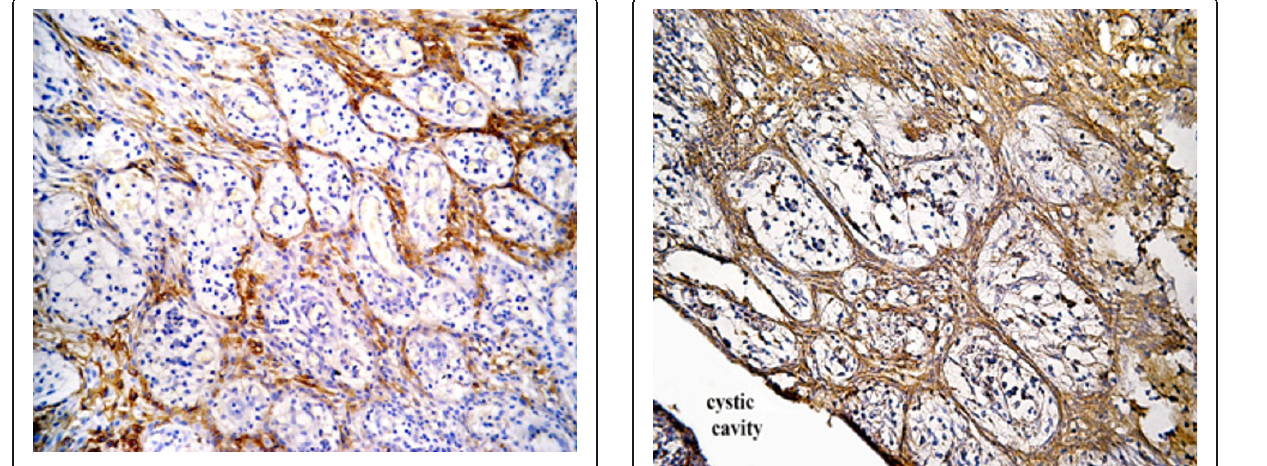
Figure 4 Photomicrograph of plexiform MCA showing cytoplasmic immunopositivty of neoplastic epithelial strands (Anti-CD10.Original magnification x40) .